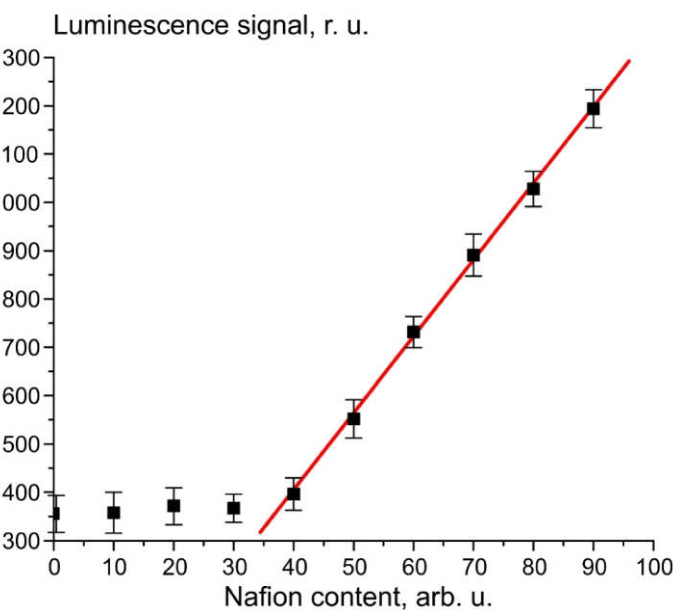
Figure 1. Dependence of the luminescence signal P on the content of Nafion in isopropanol